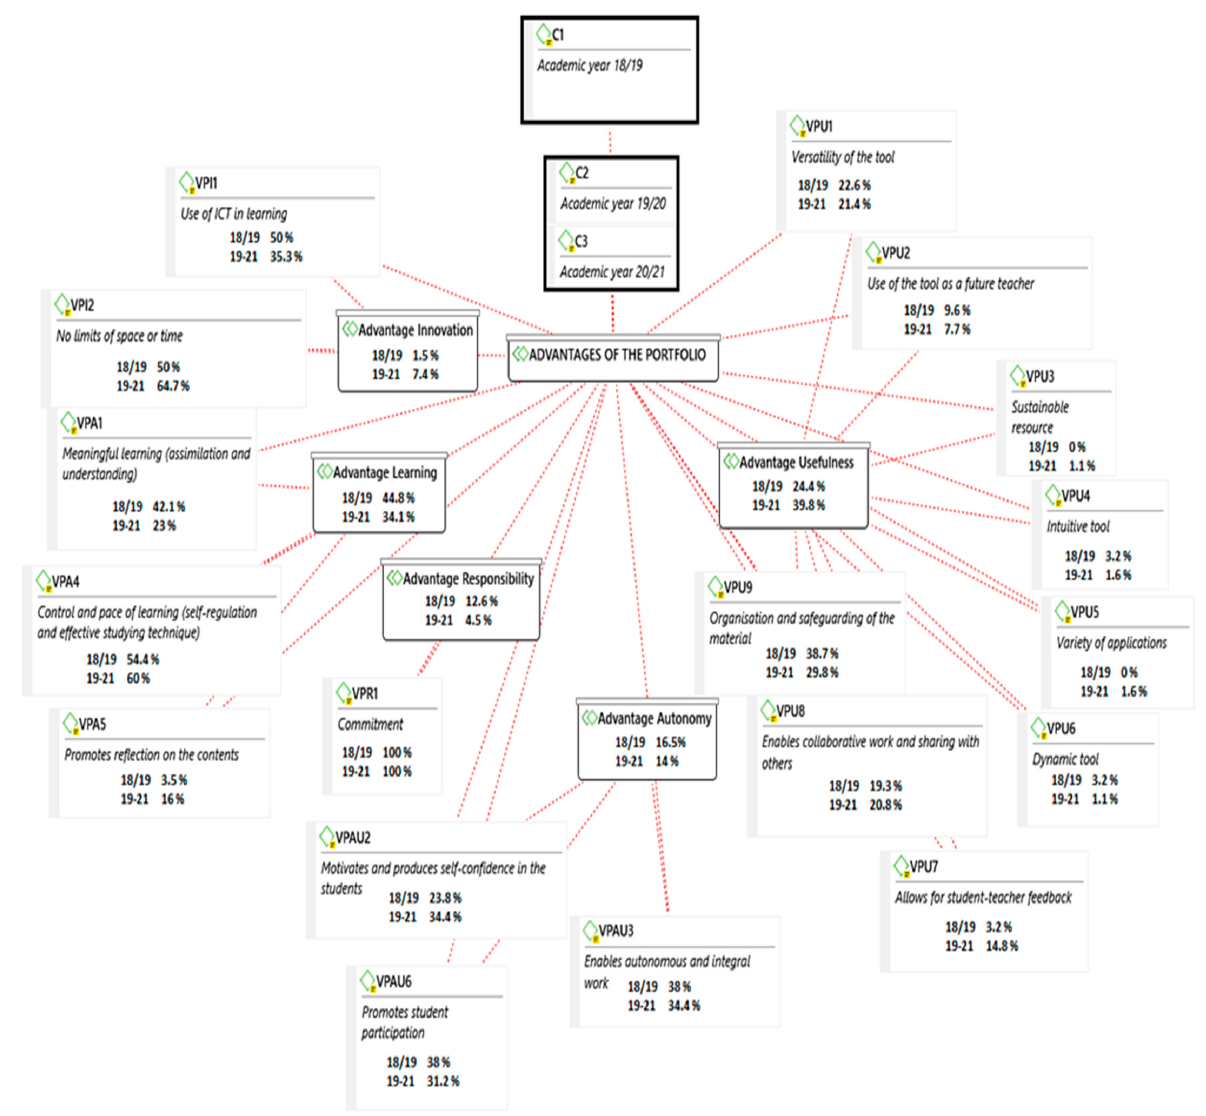
Figure 3. Advantages of the digital portfolio before and during the COVID-19 pandemic. With respect to the disadvantages (see Figure 4), there are differences in learning (IPA), with no disadvantages before the pandemic and some disadvantages during the pandemic; in this case, the acquisition of meaningful learning (IPA1) was considered a disadvantage. In autonomy (IPAU), the percentage of disadvantages was higher before the pandemic: dishonesty in carrying out the portfolio (IPAU1), not knowing how to or- ganise oneself at the beginning (IPAU2) and the lack of group coordination (IPAU3). Un- certainty (IPI) obtained a higher percentage as a disadvantage before the pandemic: feed- back (IPI1), fear of the unknown (IPI2) and being excessively alert about gathering infor- mation in class (IPI3). Time (IP) was also a disadvantage with a higher percentage before the pandemic: the time required from the students and daily effort (IPT1) obtained a lower percentage during the pandemic. The percentage of disadvantages of the usefulness of OneDrive (IPU) regarding the complexity of use of the tool (IPU1) and the required access to the Internet and to a computer (IPU2) was much higher in the pandemic years.